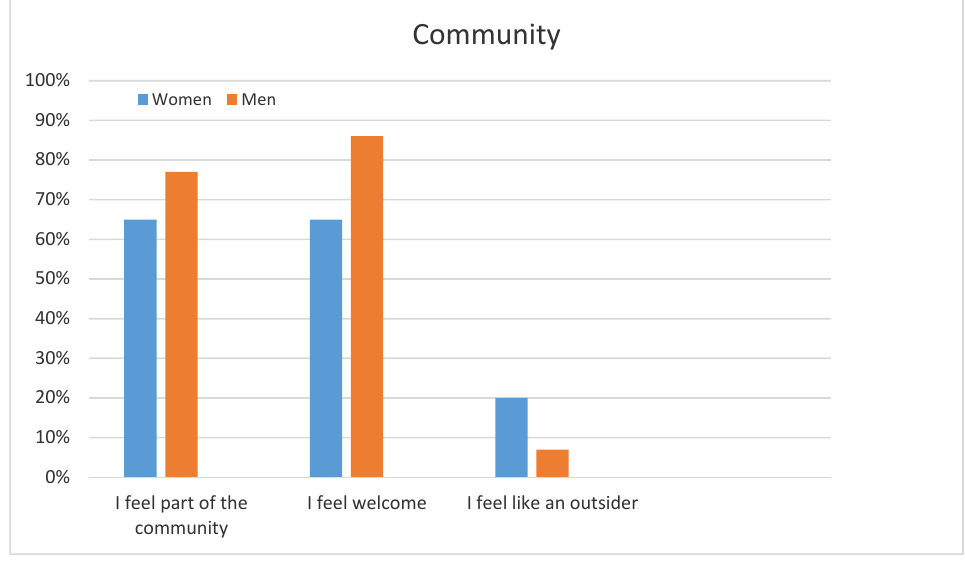
Figure 3. Views on the community.